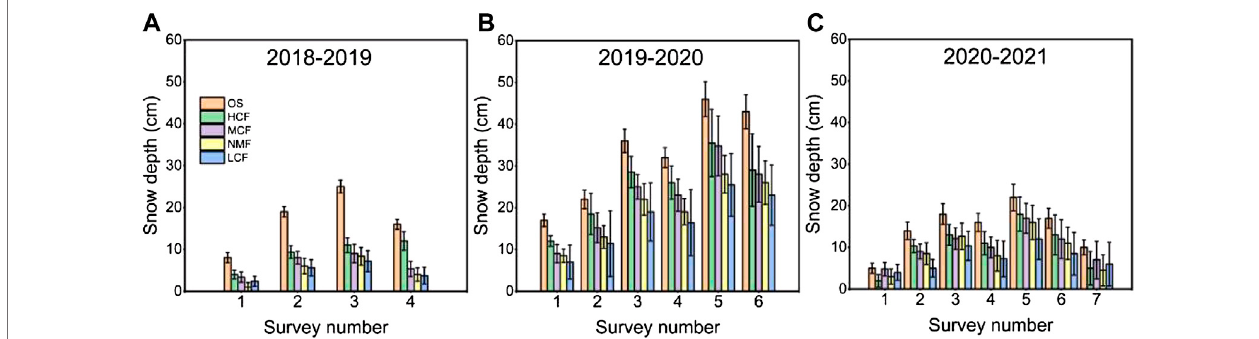
FIGURE6| Snowdepthdistributioncharacteristicsatstandlevelfor fi vesitesinthreeyears, (A) 2018 – 2019, (B) 2019 – 2020,and (C) 2020 – 2021.Thehistogramis the average snow depth ( SD ) at the plot scale, and the error bar is the standard deviation ( n = 36). Different color histograms indicate different sites: OS, open site; HCF, high-intensity cutting mixed forest; MCF, moderate-intensity cutting mixed forest; NMF, natural mixed forests; LCF, low-intensity cutting mixed forest; SD issnow depth (cm). The survey number ( SN ) is the serial number of the fi eld snow survey conducted, and snow depth surveys were carried out weekly to bi-weekly.